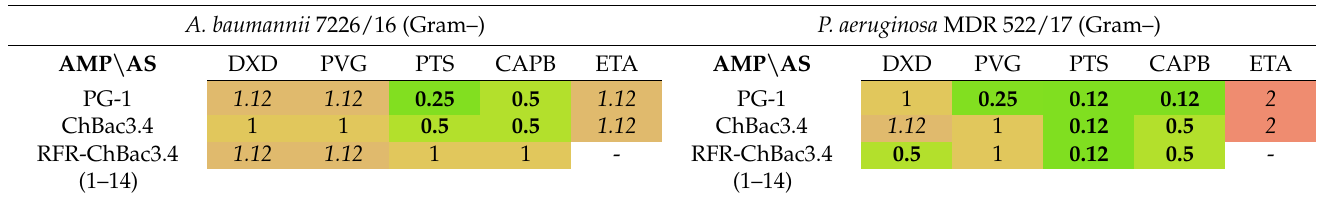
Table 4. Inhibitory effect of combinations of AMPs with antiseptics and surfactants on biofilm